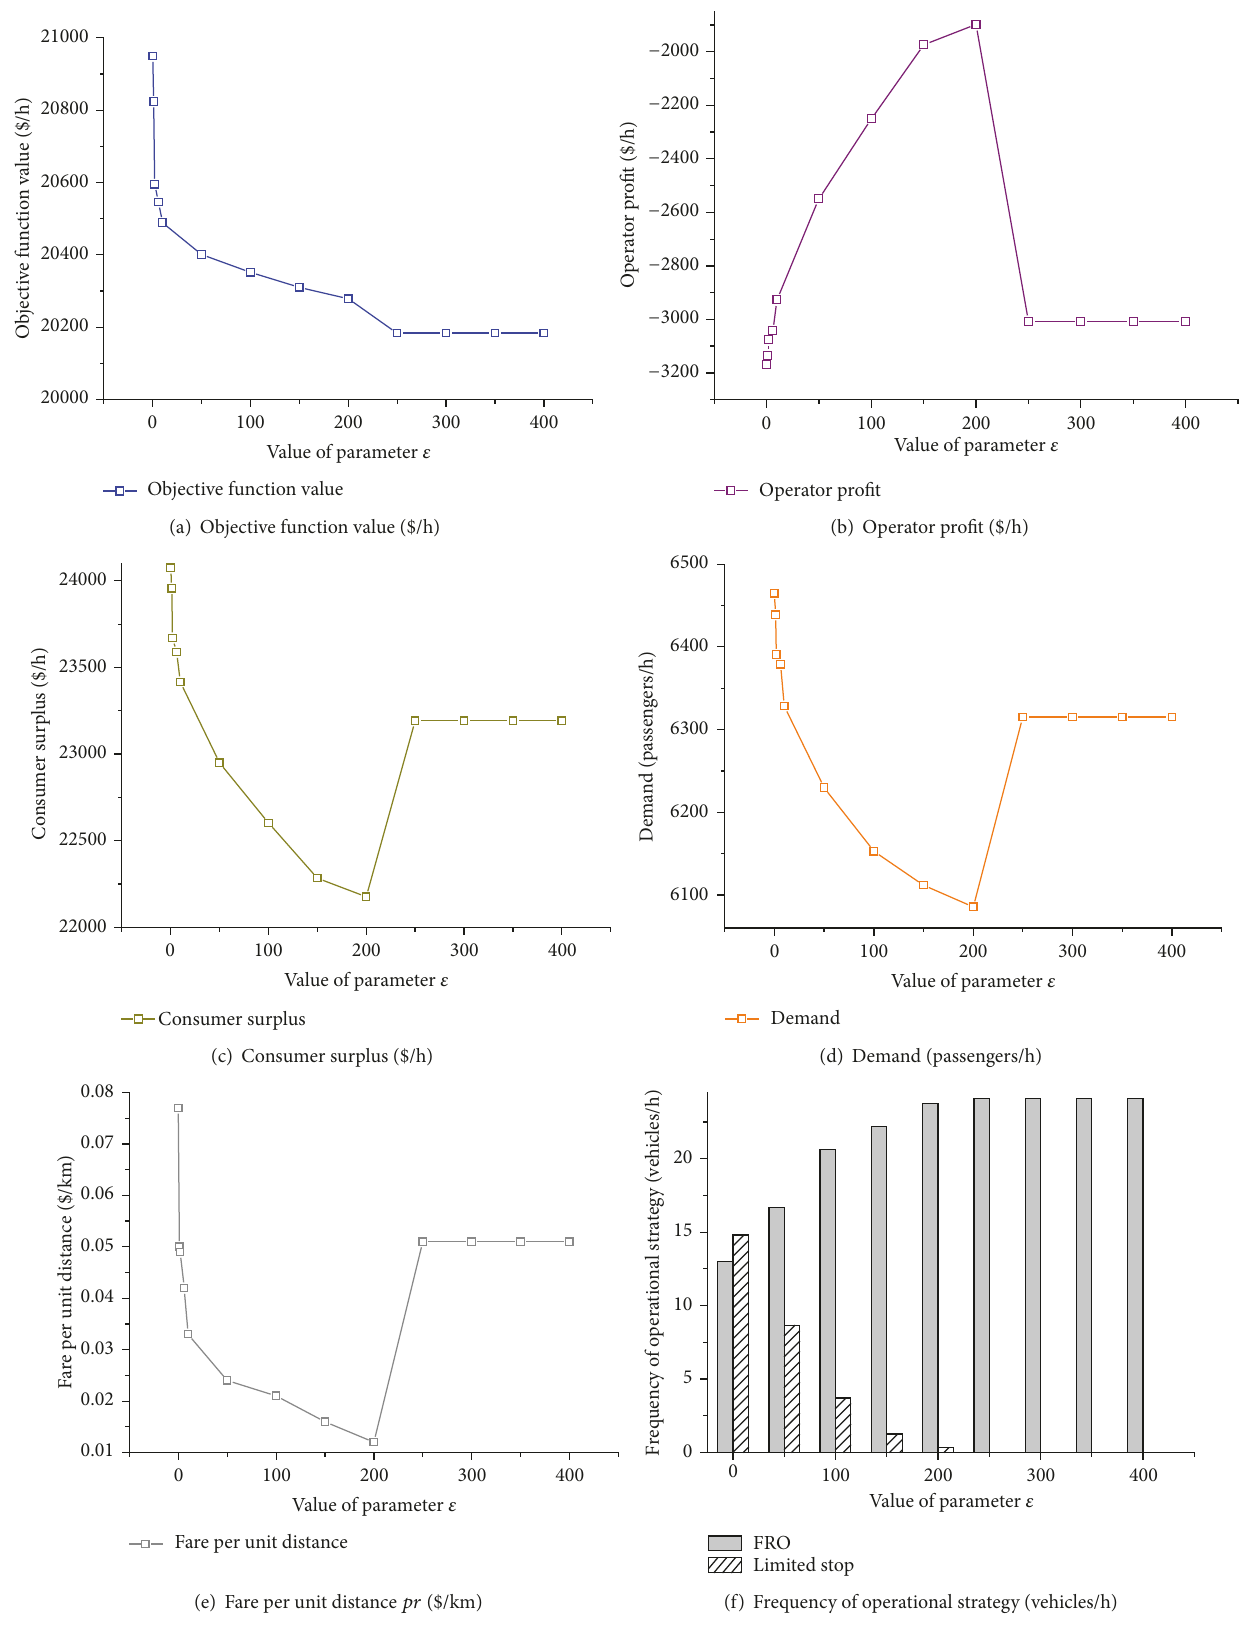
Figure 7: The effects of parameter 𝜀 related to additional service fee on optimal